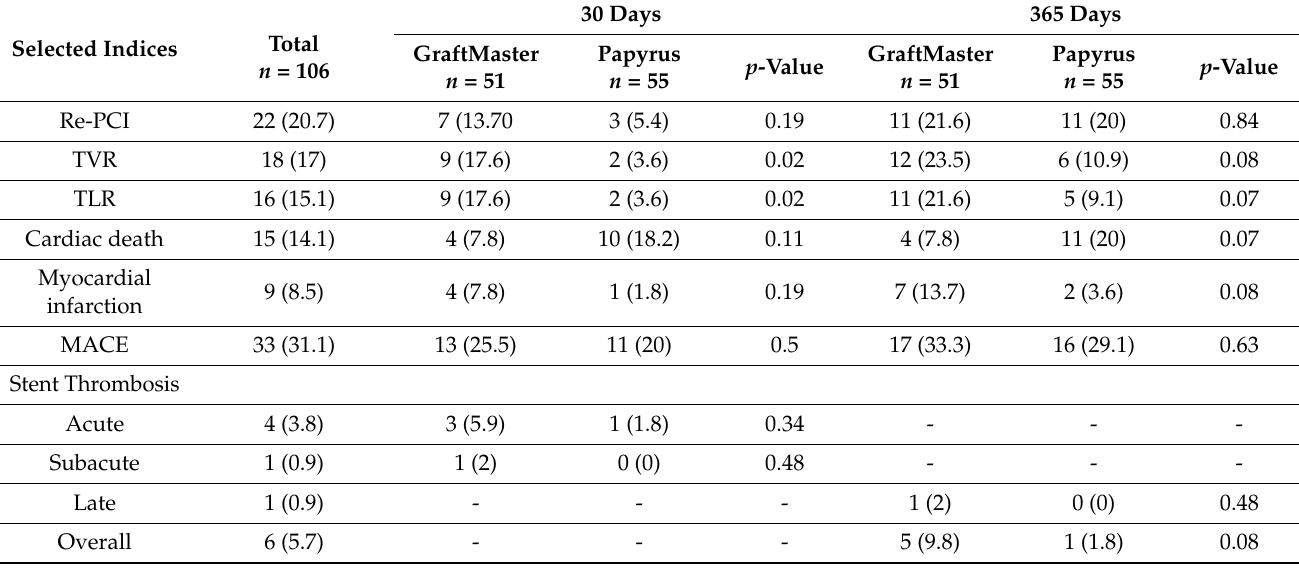
Table 4. Follow-up data according to the stent graft type within 30 and 365 days.